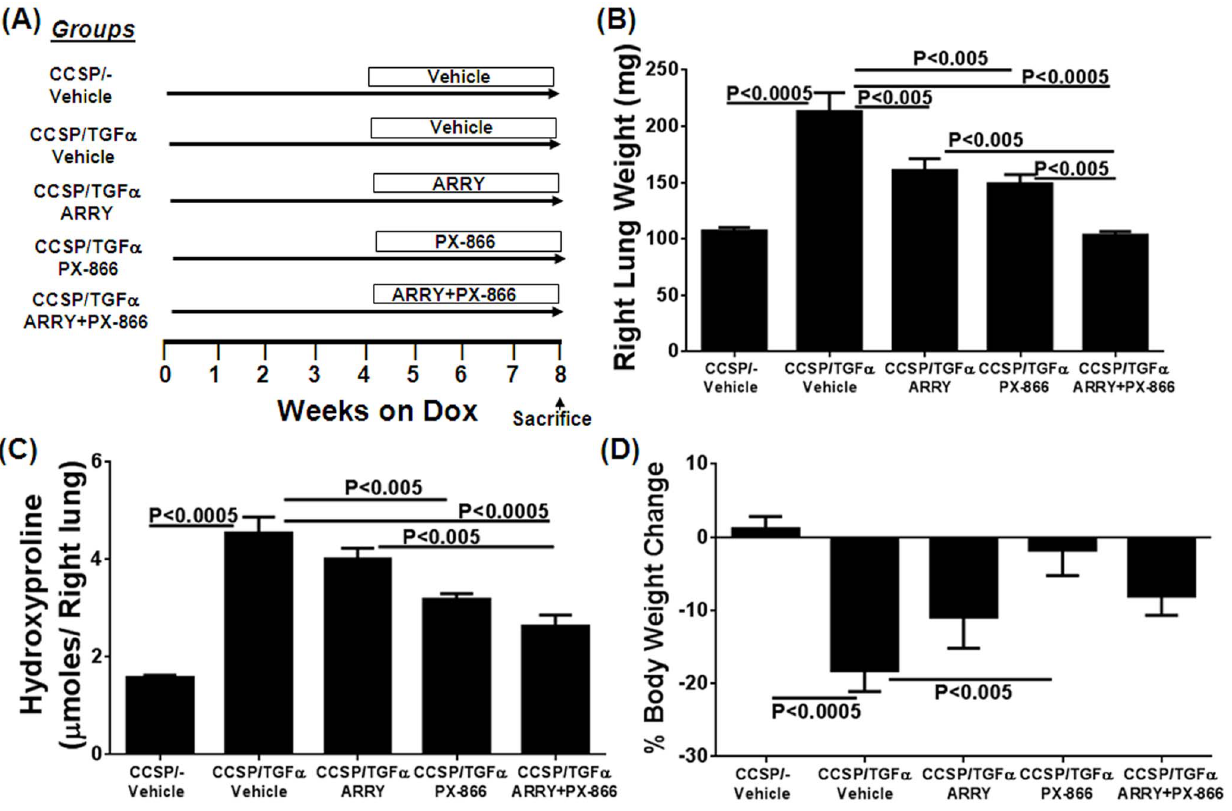
Figure 2. Inhibition of MEK and PI3K alone or in combination alters lung weights and collagen accumulation during TGF a -induced pulmonary fibrosis. (A) The treatment protocol is represented schematically. Controls included CCSP/ 2 and CCSP/TGF a mice treated with vehicle for the last 4 weeks while remaining on Dox a total of 8 weeks. (B) Changes in the right lung weights of mice treated with vehicle or inhibitors. (C) Changes in the right-lung hydroxyproline levels of mice treated with vehicle or inhibitors. Data are means 6 SEM, and statistical significance between groups was measured using one-way ANNOVA (n=8–12/group). (D) Percent change in body weights of mice treated with vehicle or inhibitors. Data are means 6 SEM, and statistical significance between groups was measured using one-way ANNOVA (n=8–12/group).